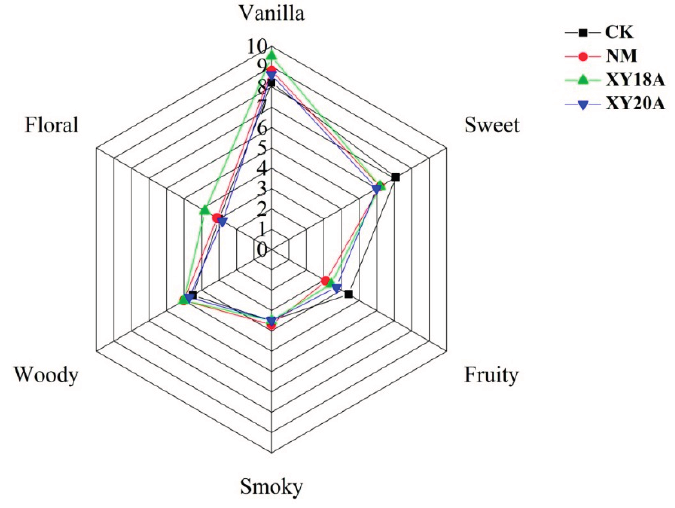
Figure 3. Sensory profile of vanilla beans from the different curing processes. Data were subjected to Duncan’s test ( p <